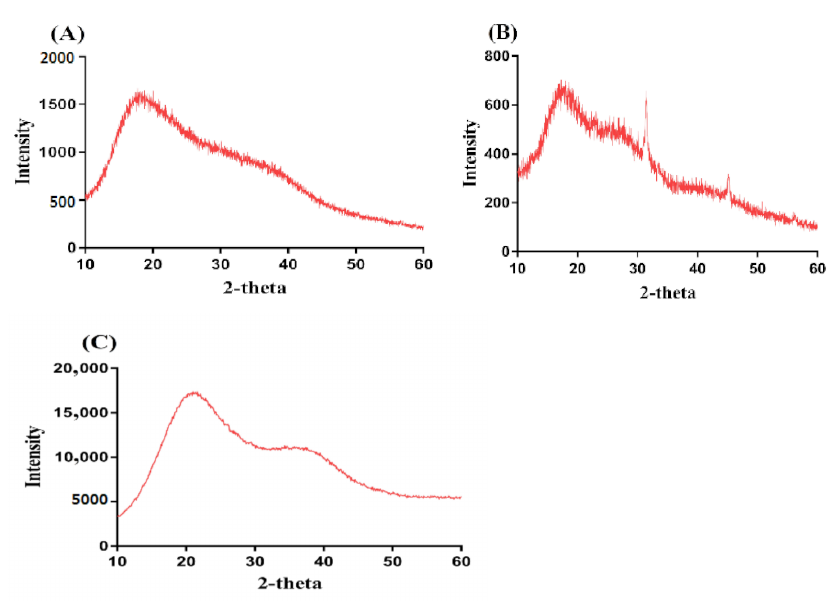
Figure 7. PXRD of ( A ) CP, ( B ) SpS, and ( C ) CP/SpScPAA